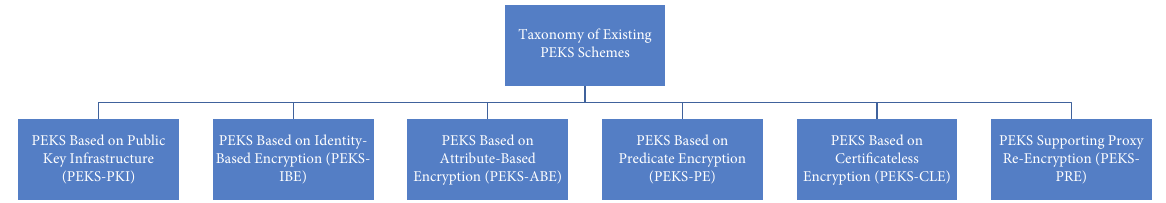
Figure 2: Classification of existing PEKS